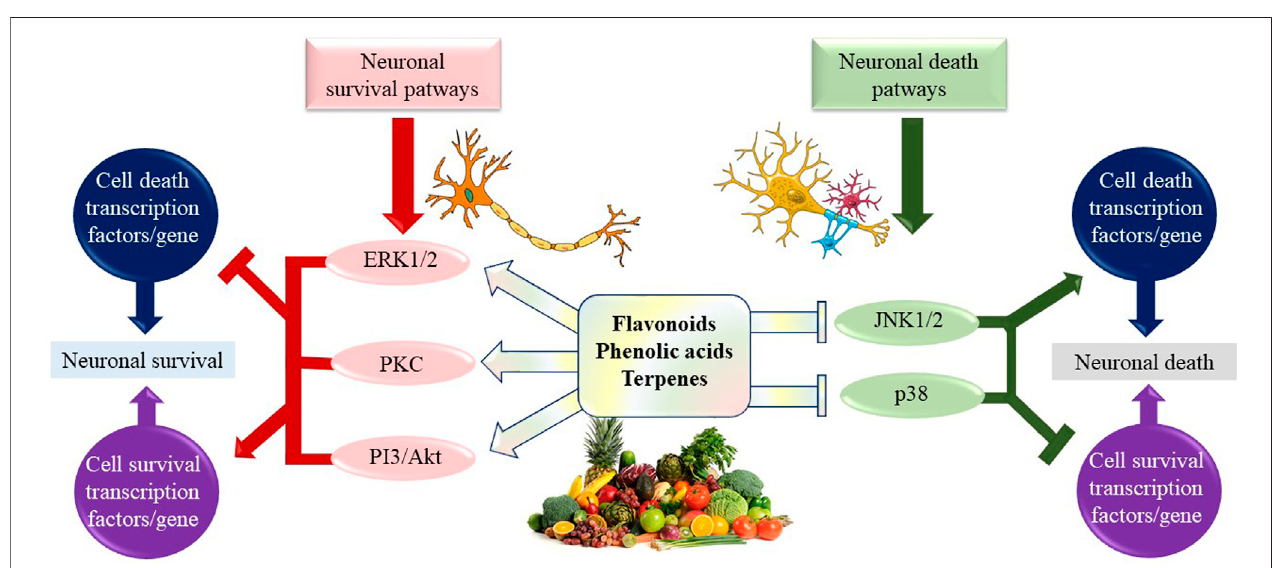
FIGURE 3 | The modulation of neuronal survival and death protein kinase pathways via fl avonoids, phenolic acids, and terpenes. The activation of ERK1/2, PI3K/ Akt,andPKCpathwaysacttostimulateneuronalsurvivalthroughtheinductionofpro-survivalorantiapoptoticgenesandbyinhibitionofpro-apoptoticproteins.JNK1/2